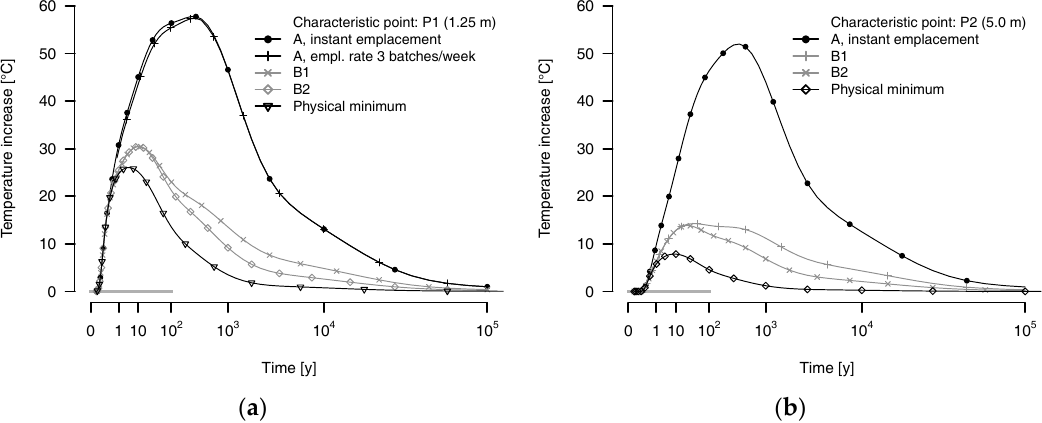
Figure 2. Comparison of temperature pulses in 1.25 m ( a ) and 5.0 m ( b ) horizontal distance from the barycenter of the center batch in the case A, case B1, and case B2 configurations. The grey bottom line indicates the pre-closure phase, assumed to last up to 100 y.